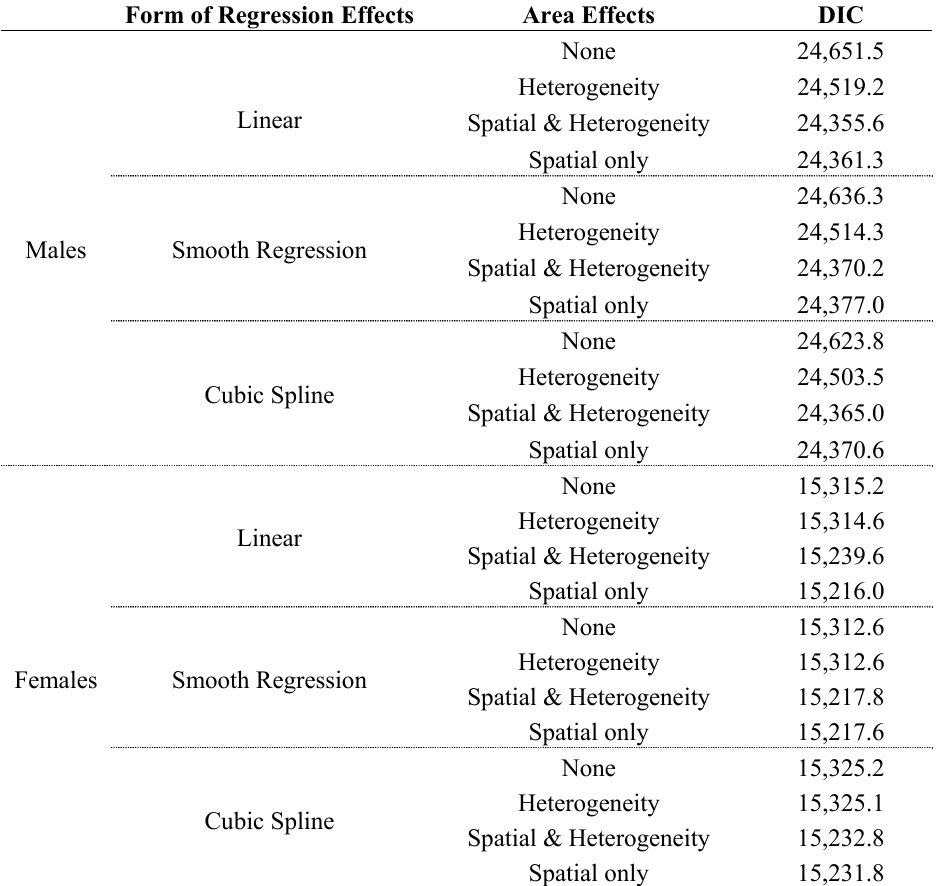
Table 3. DIC According to regression type and area effects, suicide deaths by